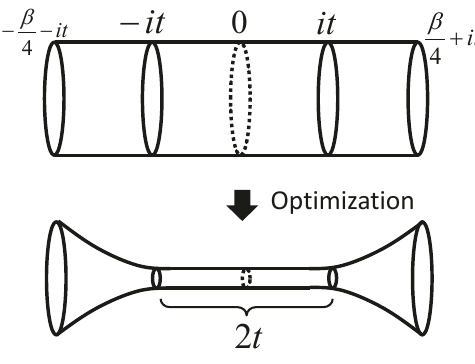
Figure 9 . The optimization of path-integral for the TFD states. The Euclidean path-integral is optimized by minimizing the Liouville action. We assumed that the Lorentzian one cannot be